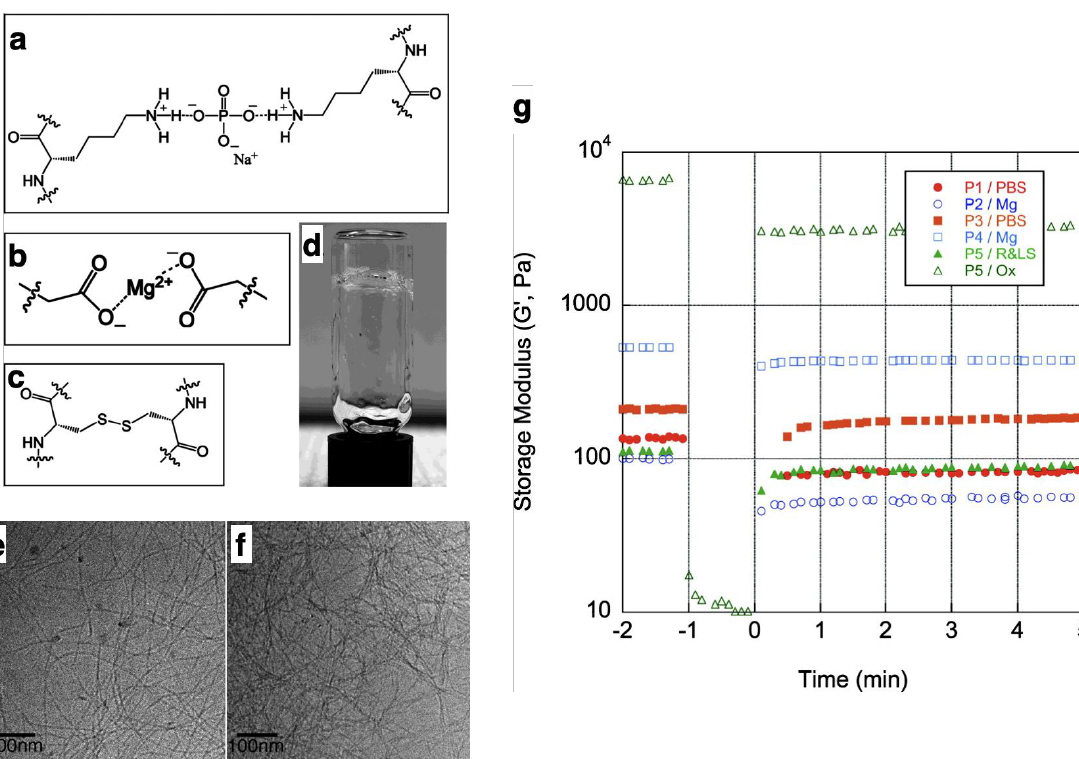
Figure 3. Three modes of cross-linking of peptide fibers: ( a ) phosphate cross-linking between lysine amines, ( b ) Mg 2 + cross-linking between carboxylates of glutamate, ( c ) covalent cross-link, using cysteine, enabling the formation of disulfide bonds, ( d ) hydrogel formation by cross-linking. Cryogenic transmission electron microscopy (cryo-TEM) images of peptide fiber before ( e ) and after ( f ) cross-linking by disulfide bonds. ( g ) Shear recovery of storage modulus of cross-linked peptide hydrogels. Shear begins at t = − 1 and is released at t = 0. Peptide hydrogels recovered considerable within 1 min (t = 1). Reprinted with permission from ref 53. Copyright 2009 American Chemical Society.